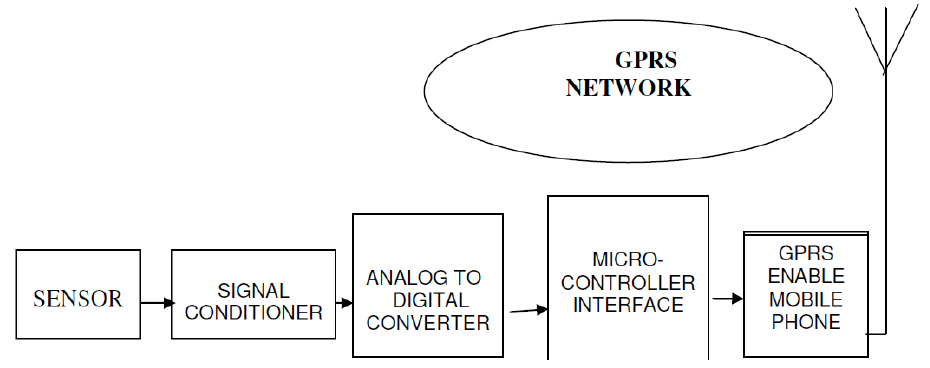
Figure 13. Block diagram of wireless SCADA [88].